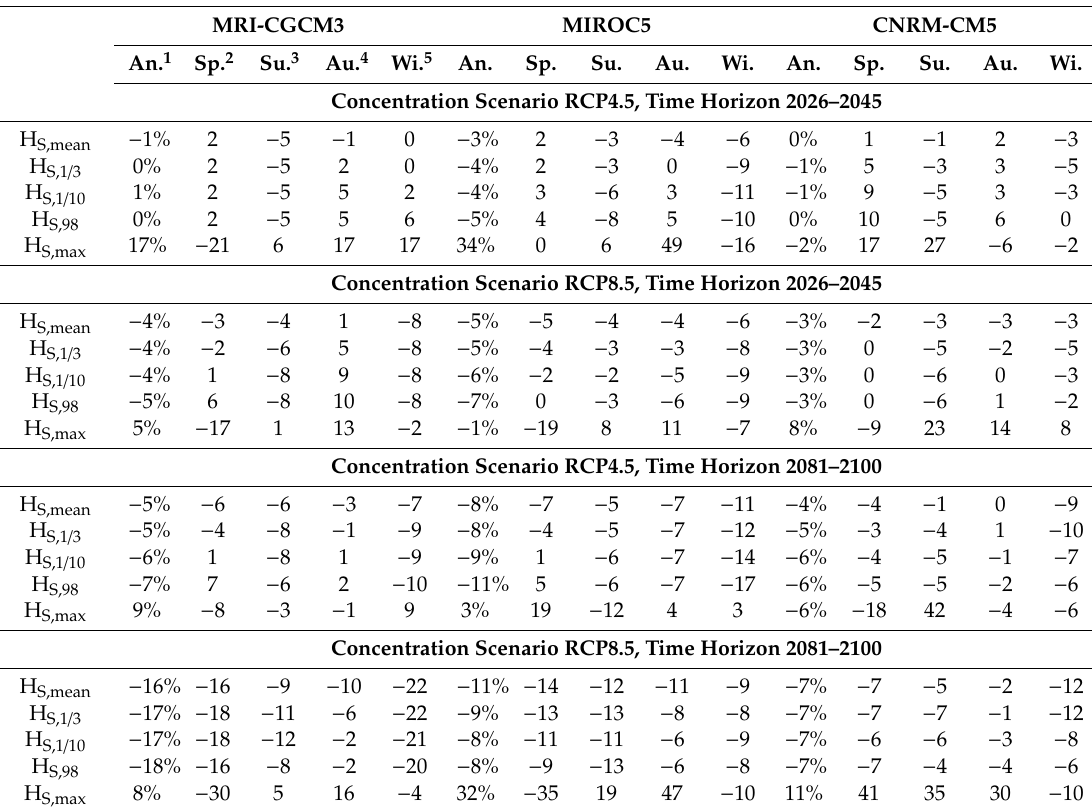
Table 5. Variations (in percentage) of the annual and seasonal statistics of the propagated values of H S at deep waters for the di ff erent concentration scenarios and time horizons of all models analyzed in comparison with each respective control